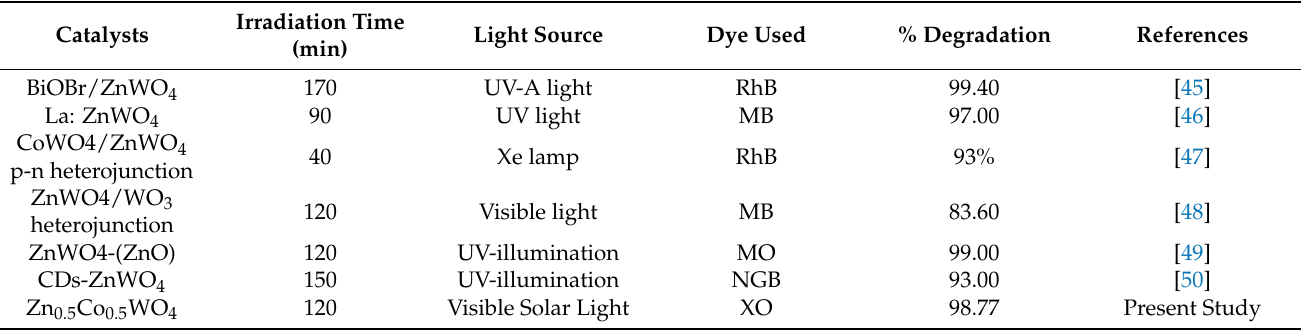
Table 3. Comparison of the literature information with the present